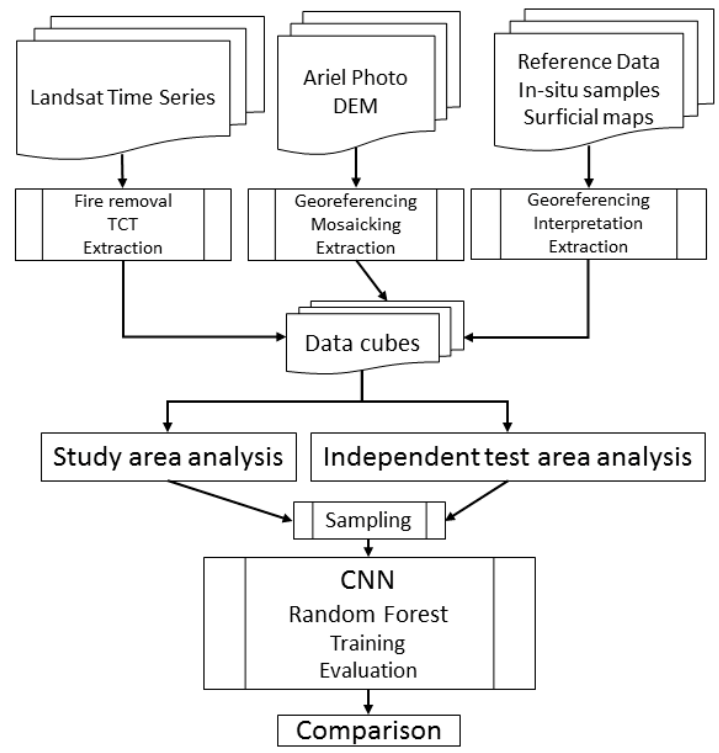
Figure 7. Assessment of Random Forest and Convolution Neural Networks for mapping surficial materials.